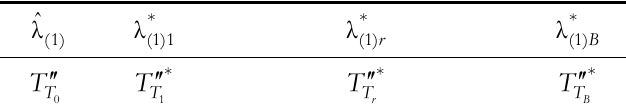
Combinazione secondo